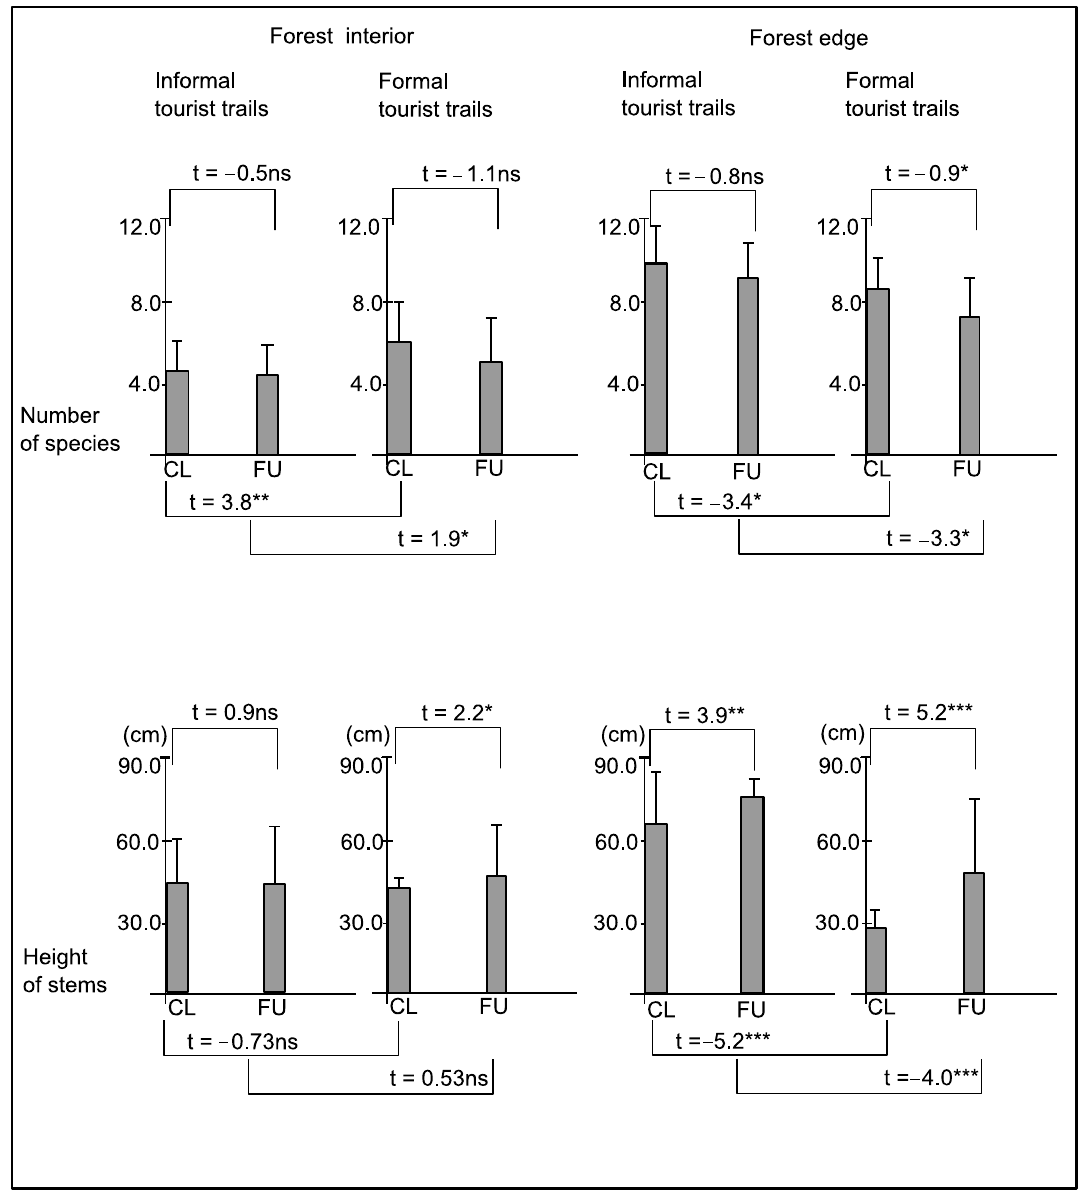
Figure 7. The mean values of number of species (±SD) and height (cm) of the tallest undergrowth plant (±SD) in closer (CL) and further (FU) plots located along informal (width < 50 cm) and formal (width > 150 cm) tourist trails within the forest interior and forest edge sites. The statistical significance level is explained in Figure 2.